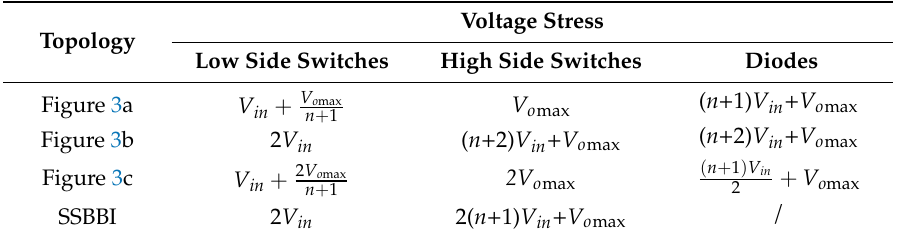
Figure 9. Comparison of the voltage conversion ratio, M , of the proposed single-stage inverter family: ( a ) As function of the duty ratio D (for n = 2), ( b ) as function of the turn ratio n (for D = 0.5). Table 6. Comparison of the voltage stress.